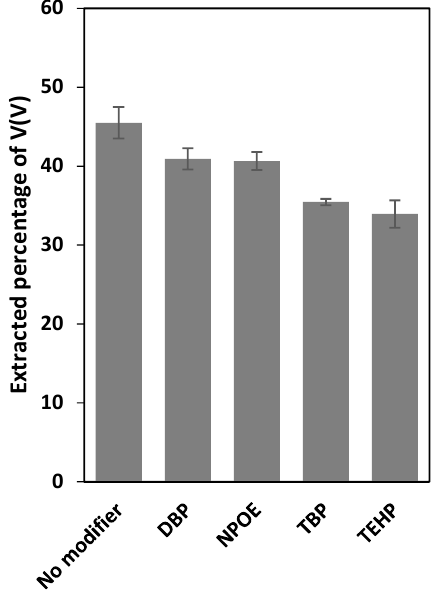
Figure 3. Effect of the plasticizer/modifier on the extraction of V(V) from aqueous 0.2 mol L −1 sulfate solutions, adjusted to pH 2.3 and containing initially 50 mg L −1 V(V) into PVDF-HFP-based PIMs incorporating either 30 wt% Aliquat ® 336 and no plasticizer/modifier or 25 wt% Aliquat ® 336 and 5 wt% plasticizer/modifier (DBP, NPOE, TBP or TEHP). PIMs/aqueous source solution contact time and temperature were 8 h and 22 ± 1 °C, respectively. Error bars = ±SD.